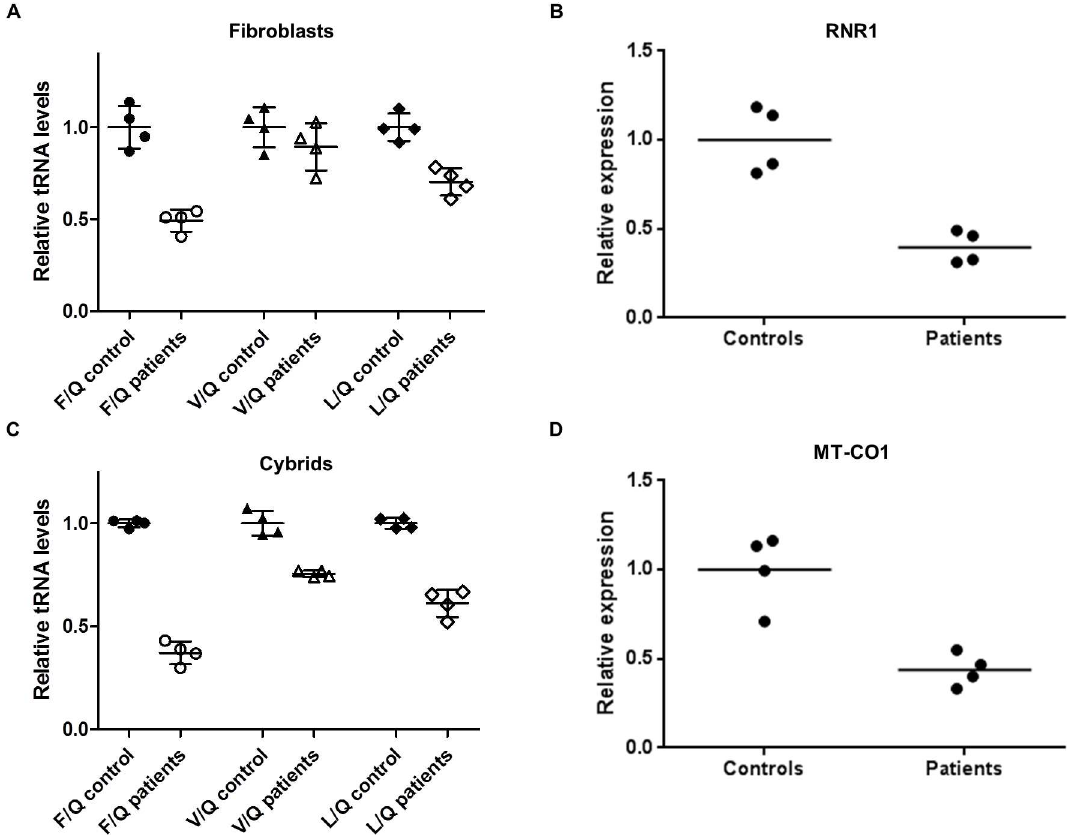
Fig 3. Reduced expression of mitochondrial heavy strand transcripts in m.547A > T patient-derived cells. (A, C) RNA from patient- and control-derived cells (n = 4 each) was analysedfor expressionof a panel of mitochondrial tRNAs by quantitative Northernblot. The graphsshow mean expressionof heavy strand tRNAs relativeto light strand tRNA Gln(Q). Valuesare expressed relative to the mean for the control cell lines in each case. Error bars indicate the standarddeviation. Heavy strand tRNAPhe and tRNALeu expressionis reducedrelativeto light strand tRNA Gln in m.547A > T fibroblasts(A, p < 0.001)and cybrids (C, p < 0.001for tRNA Phe(F), Val (V) and Leu (L)). Experiments were repeatedthree times with equivalent results. Labellingfor 5S rRNA was used to confirm equal loading.Heavy chain transcripts RNR1 (B) and CO1 (D) were measuredby quantitative RT-PCR and were reducedin m.547A > T cybrids relative to the light strand transcript ND6. Each point represents the mean of severalindependentcybrid cell lines derivedfrom a singledonor.